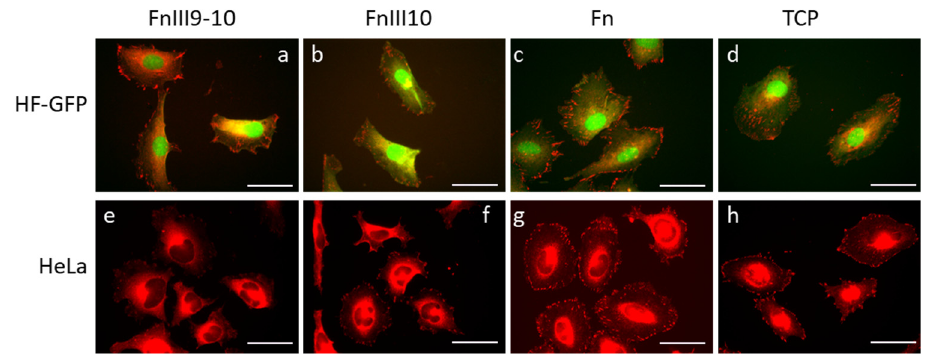
Figure 3. Fluorescence micrographs showing GFP-transfected human fibroblast (HF-GFP, a – d ) and HeLa ( e – h ) cell adhesion on FnIII9-10, FnIII10 and Fn -modified biochip surfaces. A tissue culture plate (TCP) was used for control. The cells were immunostained for vinculin (red filter). The scale bar is 50 µm in all images.